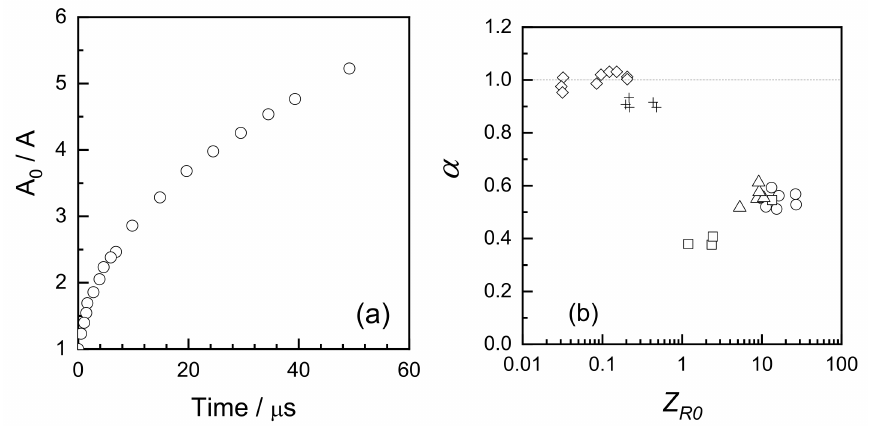
Figure 7. Pulse radiolysis of poly(ethylene oxide) in dilute N 2 O-saturated aqueous solutions: ( a ) Kinetics of radical recombination in the second-order kinetics coordinates ( M n = 218 kDa, polymer chain concentration 2.2 µ M, initial radical concentration ca. 120 µ M, Z R0 ca. 54); ( b ) Dependence of the α parameter (Equation (5)) on the average initial number of radicals per chain, Z R 0 . Data for PEO oligomer ( M n = 400 Da) at oligomer chain concentrations of 110 µ M (+) and 1100 µ M ( (polymer chain concentration 4.7 µ M, (cid:52) ) and M n = 277 kDa (polymer chain concentration 1.6 µ M,